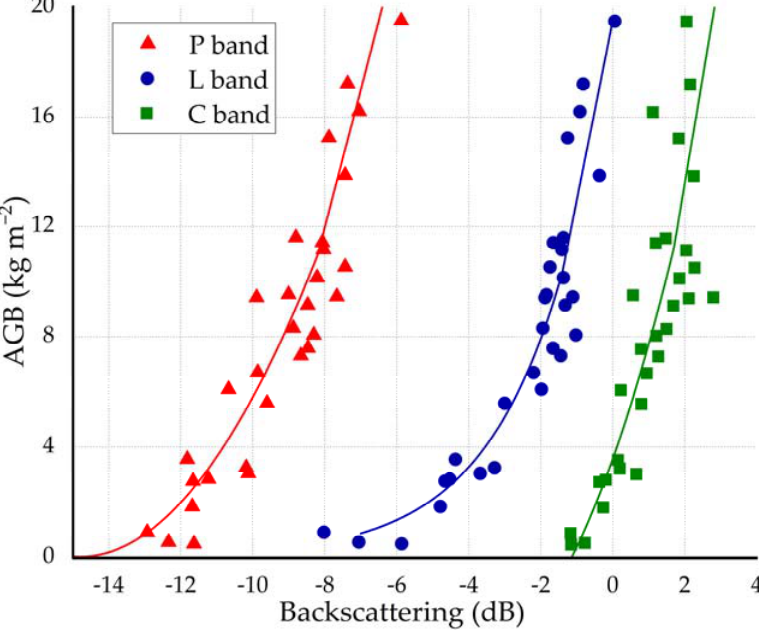
Figure 9. Backscattering of the P, L, and C bands versus measured